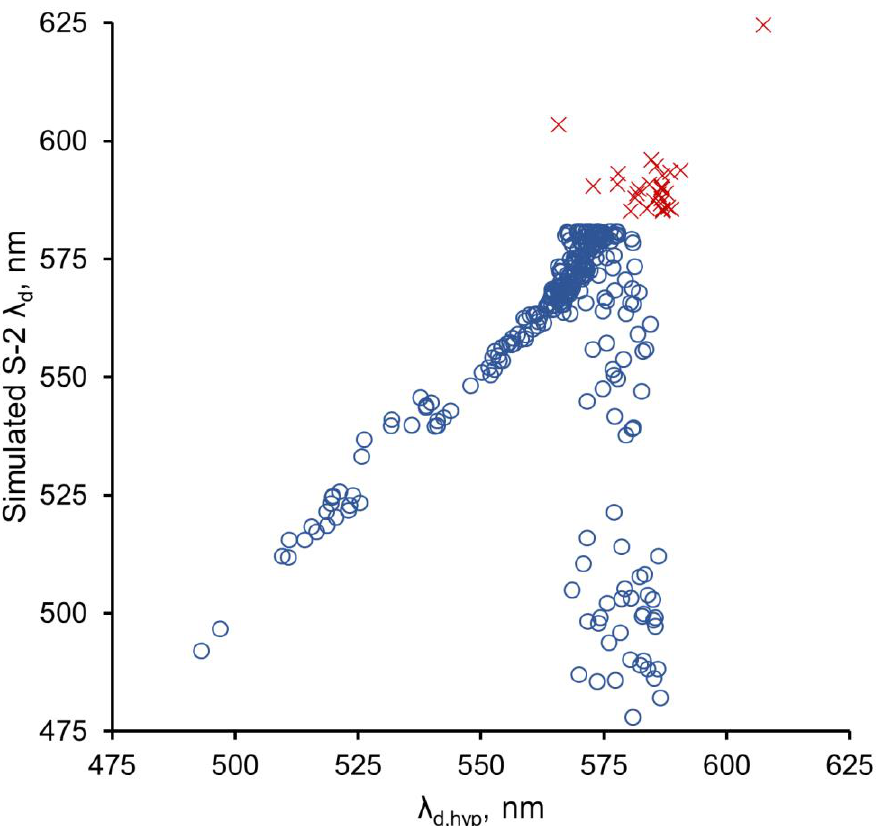
Figure 4. Wang method results for the S-2 MSI sensor for α corrections applied to angles between 30° and 230° ( ○ ); × represents uncorrected values outside the range where corrections were applied. Similar results were obtained for the S-3 OLCI and Landsat 8 OLI sensors.